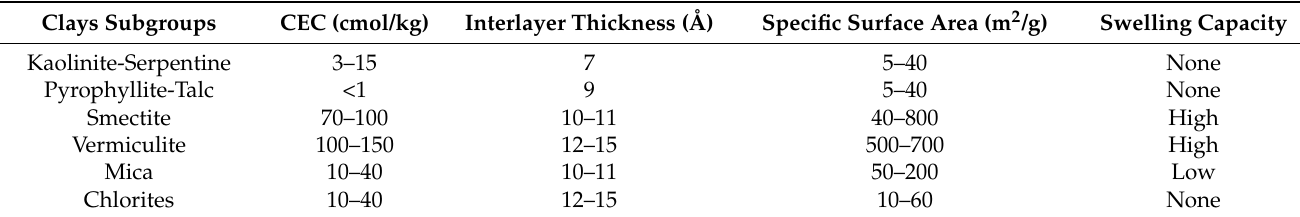
Table 1. Properties of the different subgroups of clays